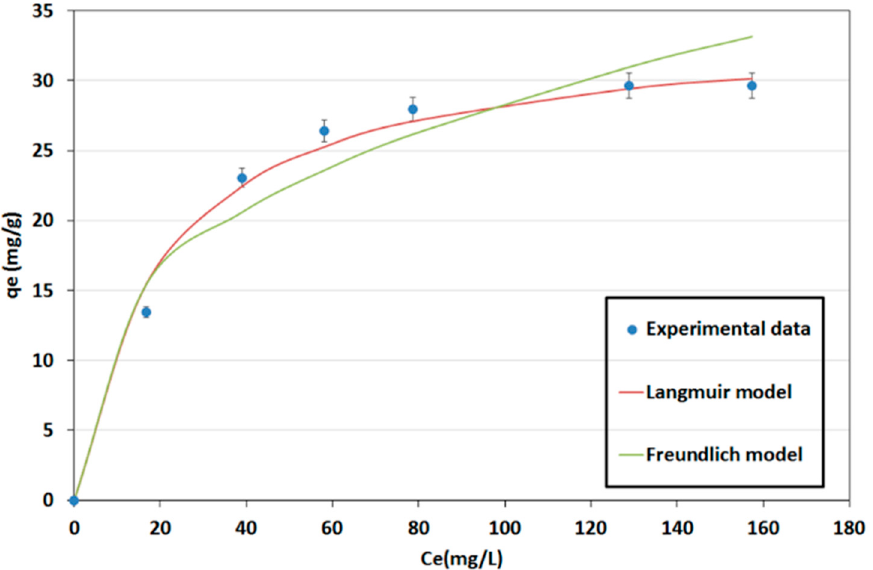
= 1 g/L; tempera- 2